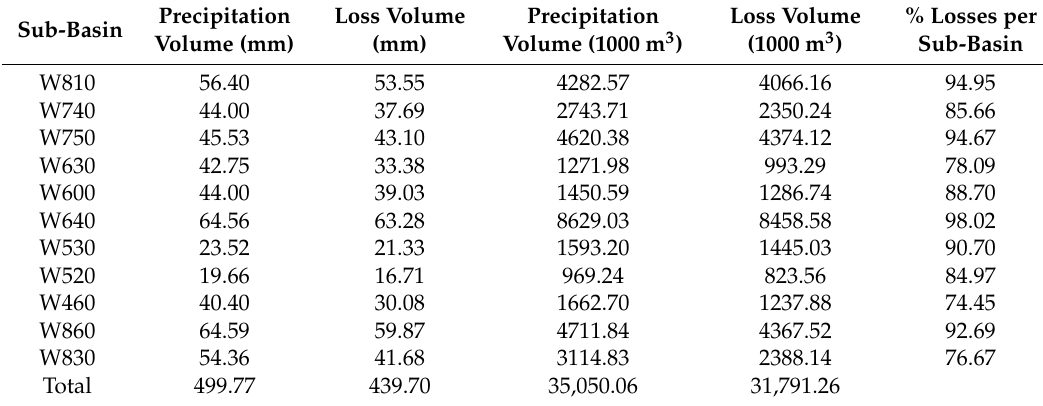
Table 15. Basin losses of